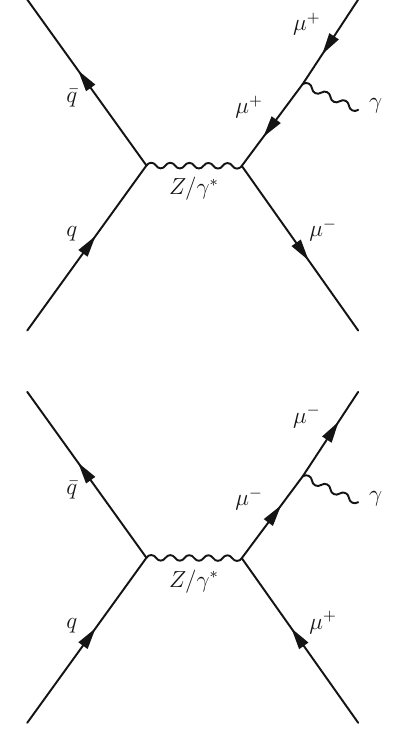
Fig. 2 The lowest order Feynman diagrams for the Drell-Yan process in pp → Z → μμγ . The background exhibits a peak in m μμγ at the Z boson